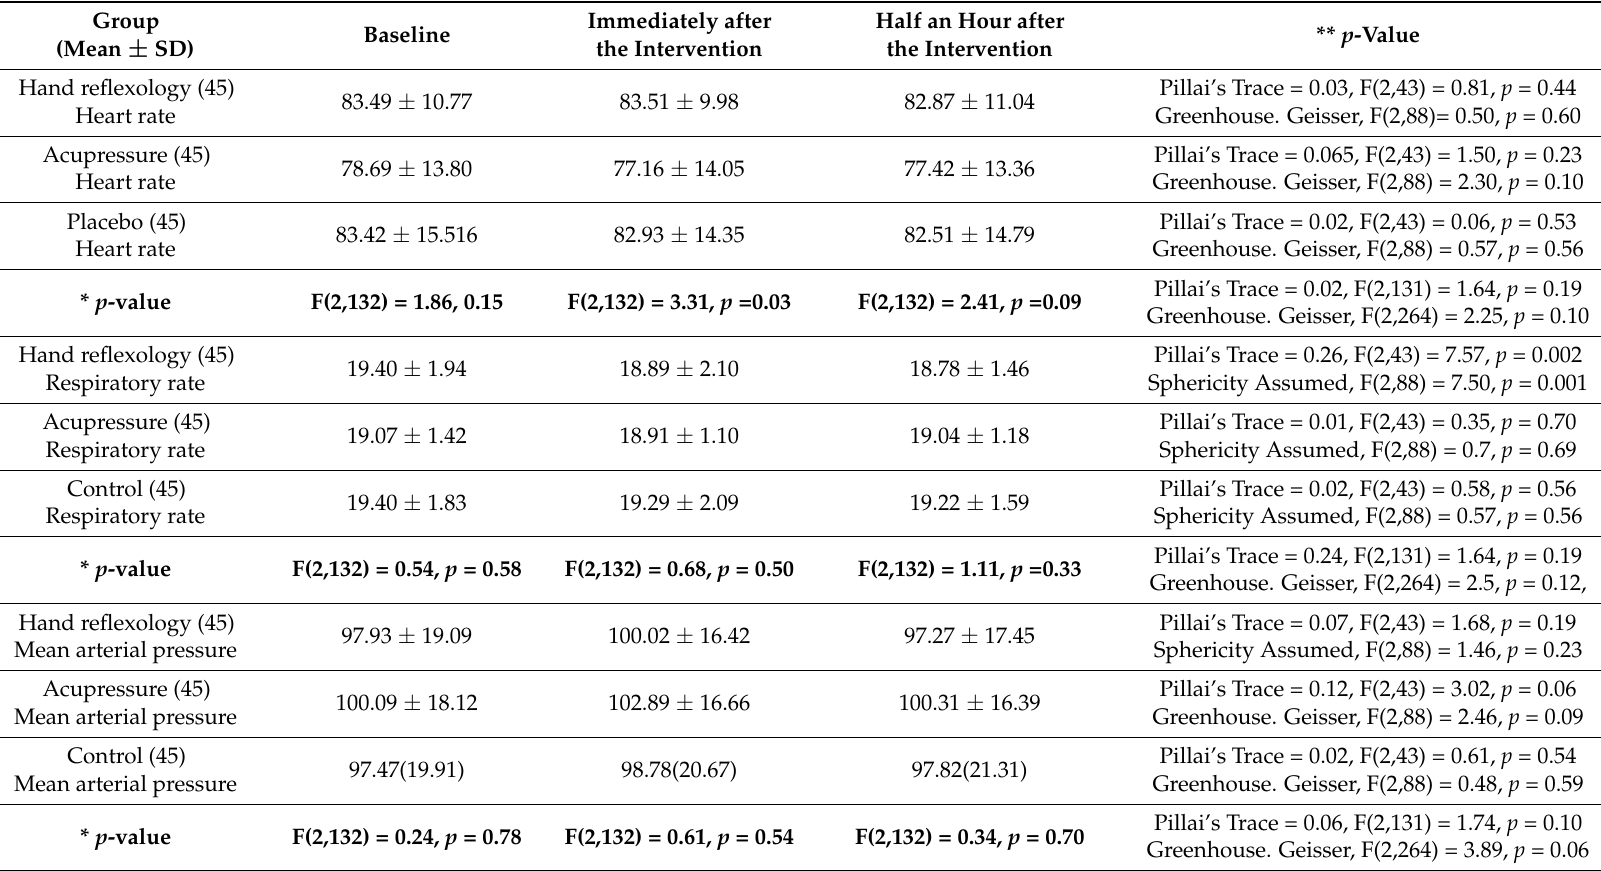
Table 2. Comparison of the mean scores of vital signs before the interventions and at two follow-ups within and between the